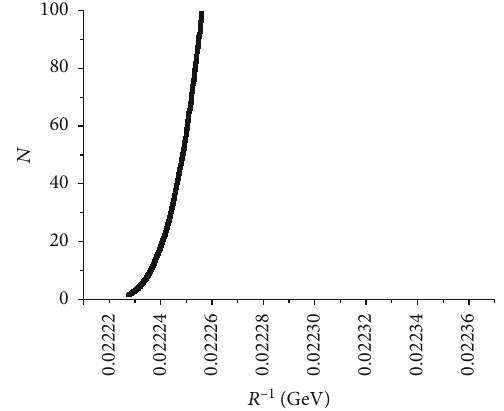
= 0 : 45 ð GeV Þ − 1 , ω = 4 : 6 ð GeV Þ , 0